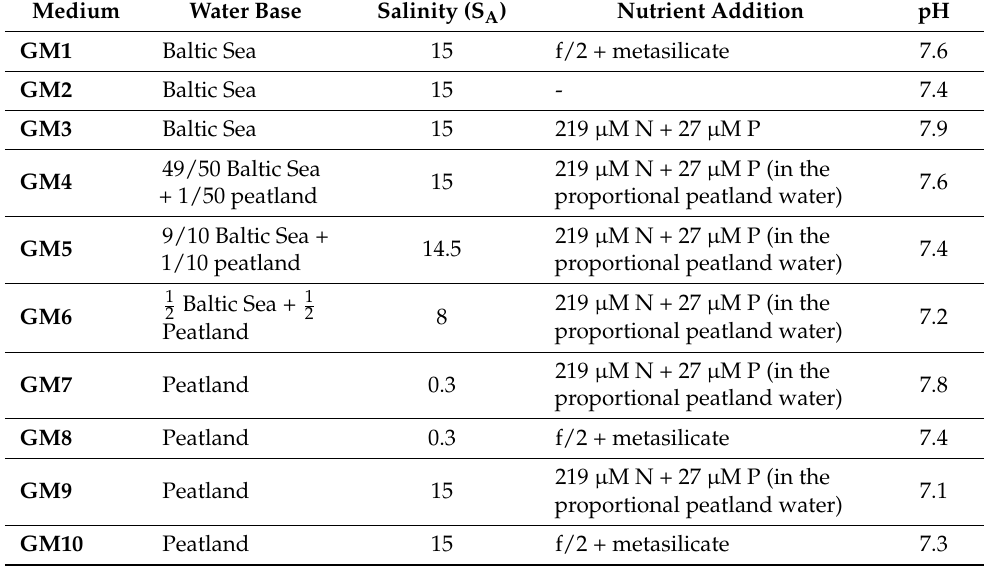
Table 1. Media composition for experimental growth medium GM1 to GM10 with the respective salinities (S A ) and respective nutrient additions of f/2 + meatsilicate, inorganic nitrogen (N)